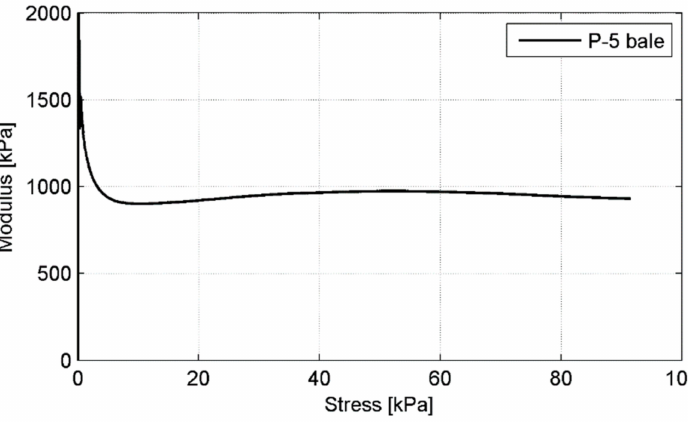
Figure 15. Young’s modulus variability for P-5 bale under increasing